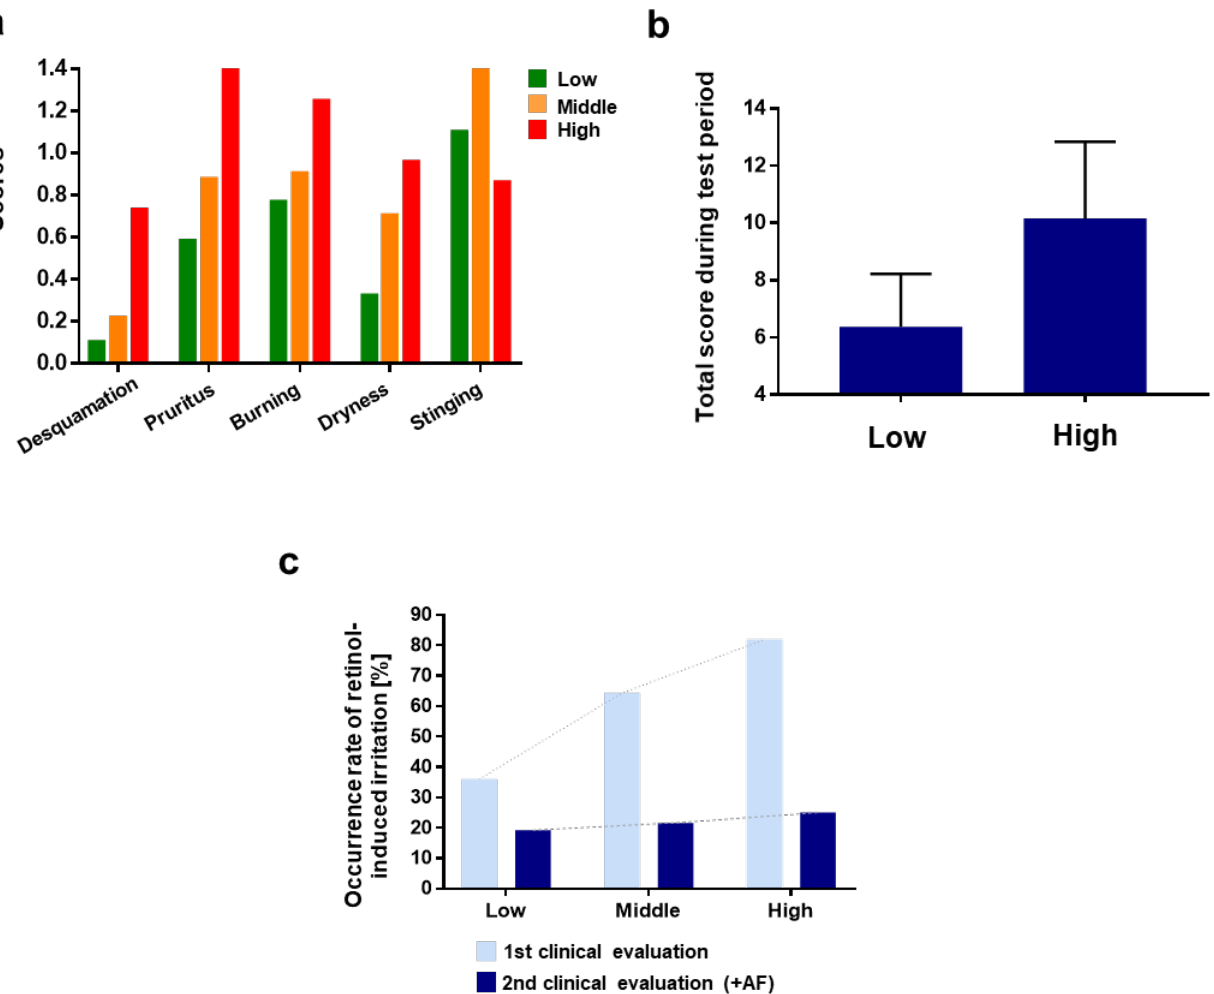
Figure 5. Bar plots illustrating polygenic risk score model and validation. 3300 IU retinol cream with AF to 91 individuals. Test subjects were categorized into three groups: high-risk score (>75, 31 individuals), middle-risk score (65~75, 33 individuals), and low-risk score (<65, 27 individuals) ( a ) Irritation score of each type of irritation for three risk score groups. The scores for types of irritation of individuals during the test period were summed and averaged by risk score groups. ( b ) Total score during test period. ( c ) Comparison of occurrence rate of irritation on each risk-score group. The dichotomous question (whether retinol cream is irritant: Y/N was asked to test subjects. In the first clinical evaluation, the retinol without AF was given. The retinol with AF was given in second clinical evaluation.